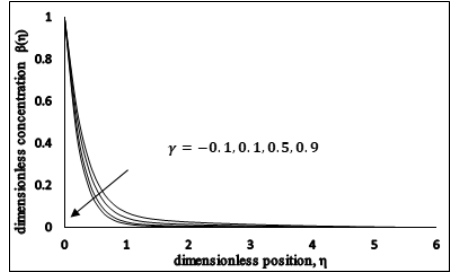
Figure 15. Dimensionless Concentration vs γ